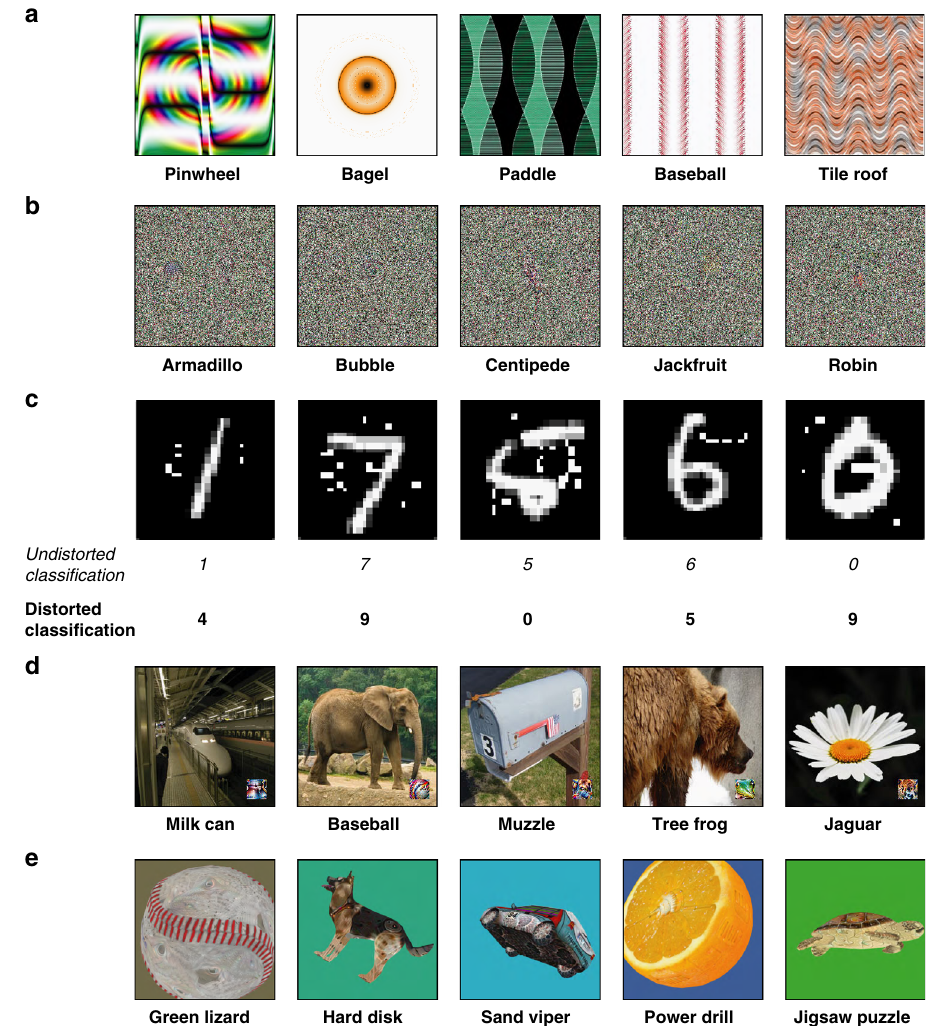
Fig. 1 Examples of adversarial images that “ fool ” Convolutional Neural Nets trained to classify familiar objects, with labels indicating the machine ’ s classi fi cations. a Indirectly encoded “ fooling ” images (from ref. 14 ). b Directly encoded “ fooling ” images (from ref. 14 ). c Perturbed adversarial images that cause the machine to classify one kind of digit as another (from ref. 15 ). d The LaVAN attack 13 can cause a machine to misclassify a natural image even when the noise is localized to a corner of the image. e “ Robust ” adversarial images 12 are renders of 3D objects that are misclassi fi ed from multiple viewpoints (and can even be physically produced in the real